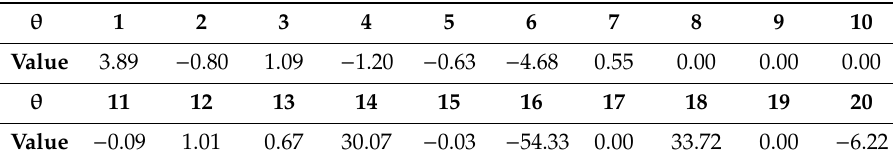
Table 2. Parameter values optimized using the cost function of the Equation (6). Some parameters as it can be seen have values close to zero.